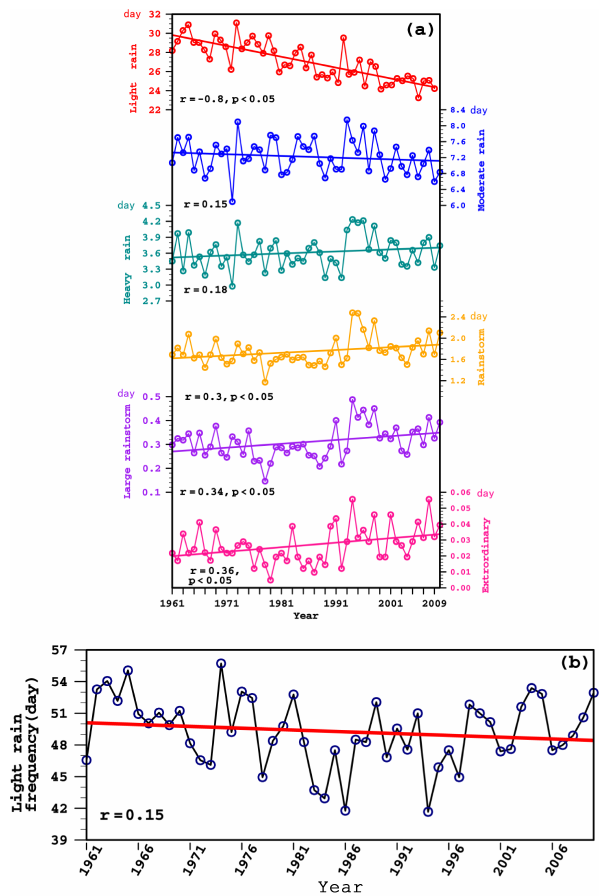
Figure 3. Interannual variations with their anomalies (broken lines) and trends (straight lines) in (a) various precipitation intensities in the high aerosol concentration area in the EC region and (b) light rain in the relatively clean area of the Tibetan Plateau.